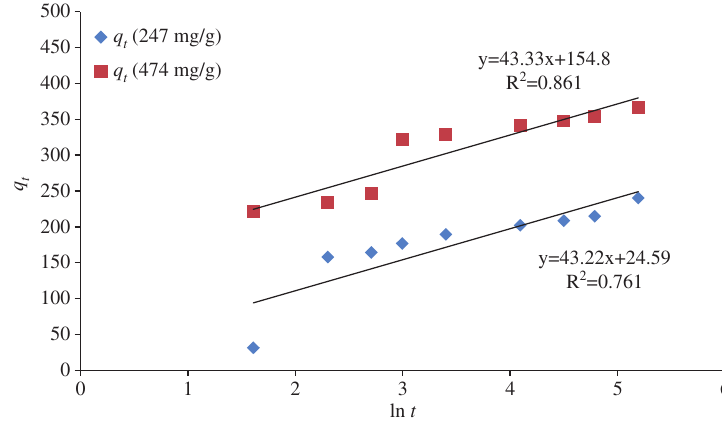
Figure 10: Elovich model of Pb(II) onto S. sesban L. at 30 °